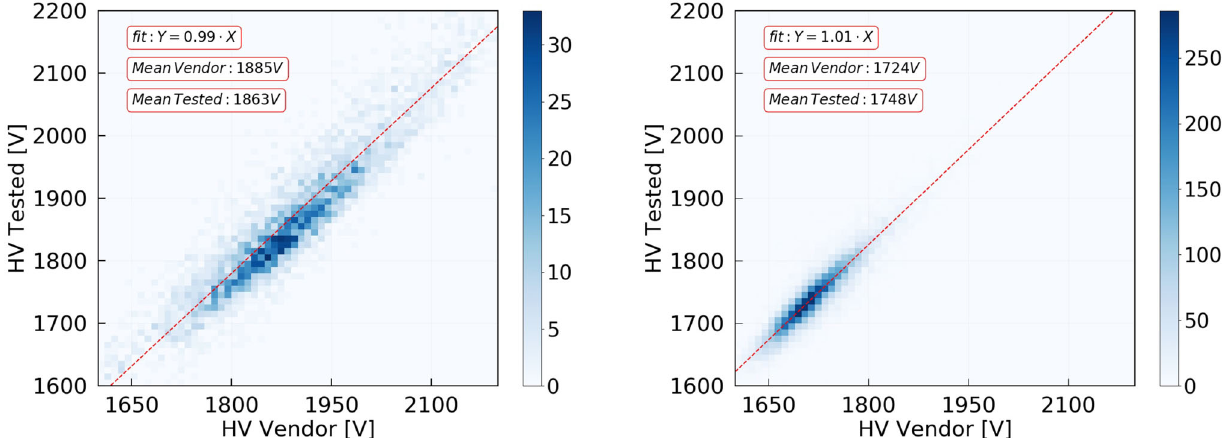
Fig. 13 Comparison between the working HV for a gain of 1 × 10 7 of all qualified bare PMTs, measured by JUNO and the suggested HV values from the manufacturers. Left: HPK; right: